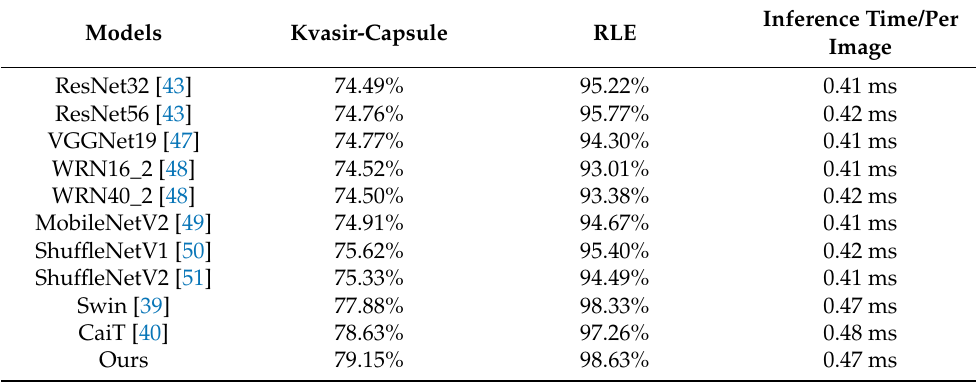
Table 1. The results of comparison